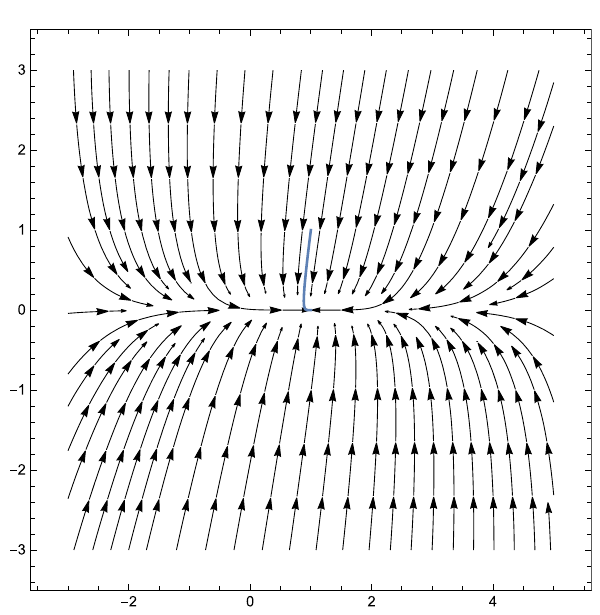
Fig. 2 The phase plot for stable F 1 at γ = 2, α 2 < 3